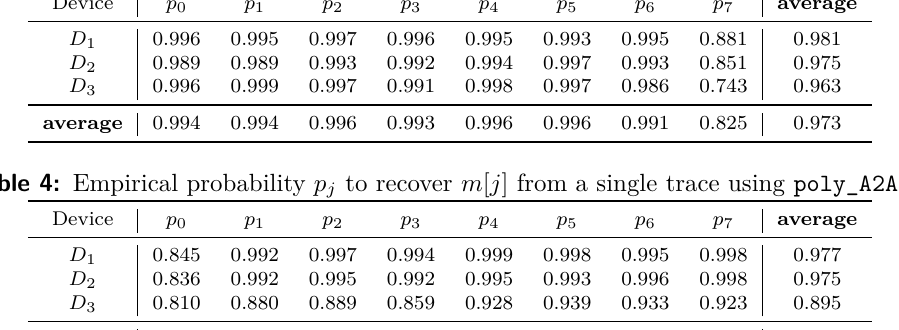
Table 3: Empirical probability p j to recover m [ j ] from a single trace using POL2MSG() . Device